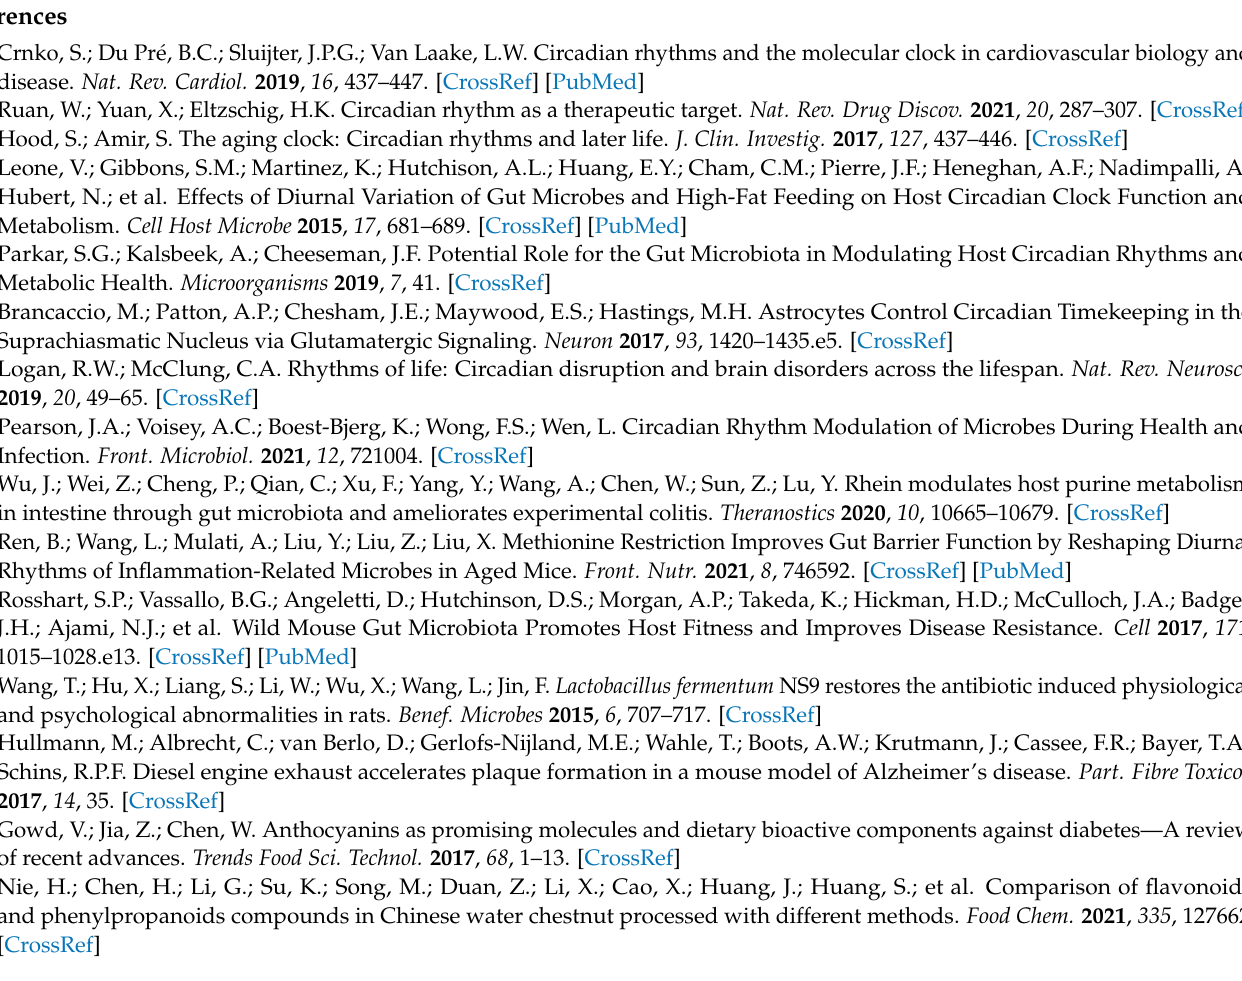
HPLC analysis. Figure S2: Effect of FCF on the food intake (A) and water intake (B) of the circadian rhythm disorder mice; Figure S3: Colon tissue injury score of each group; Figure S4: Principal component analysis of the gut metabolites among the three groups; Supporting